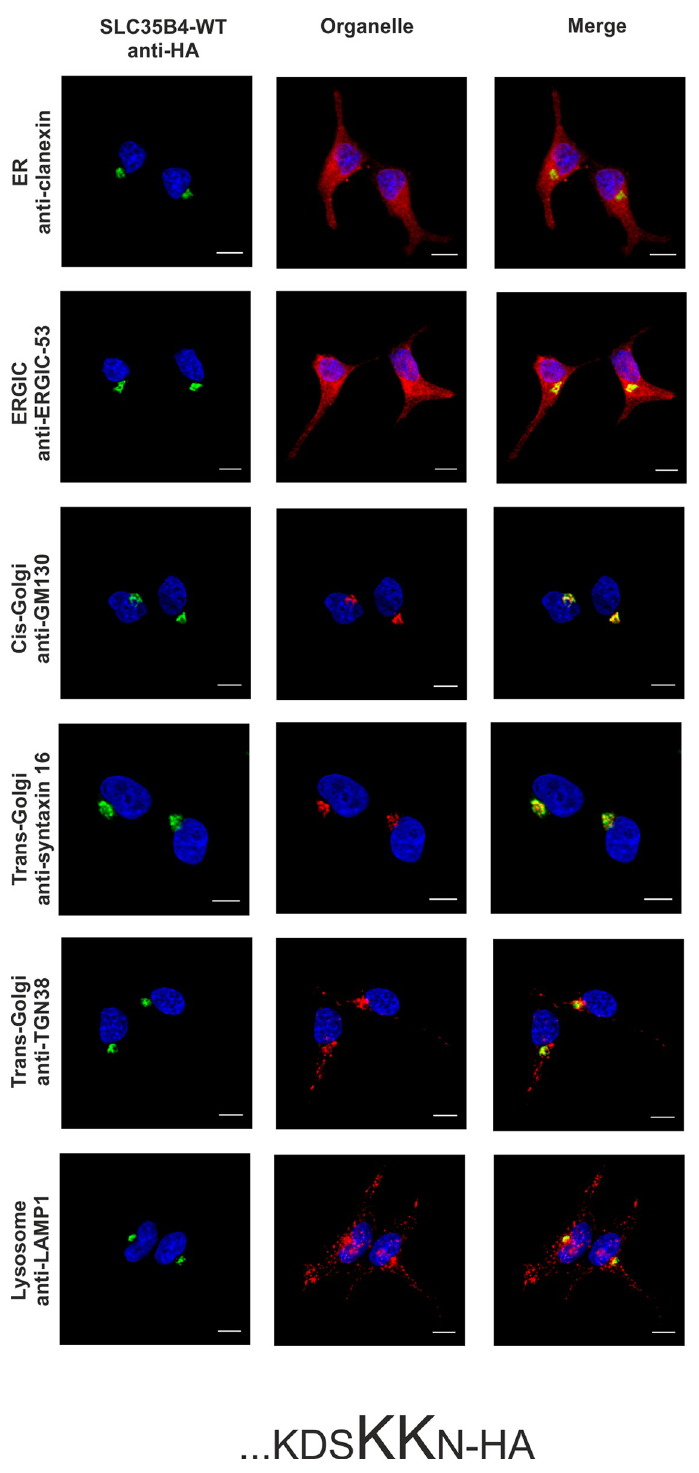
Fig 2. Subcellular localization of ... KDSKKN-HA, human SLC35B4 with HA-epitope at the C-terminus in the wild-type HepG2 cells. Stably transfected wild-type (SLC35B4-WT) cells, overexpressing SLC35B4 variants, were subjected to indirect immunofluorescent staining with anti-HA (green) and anti-organelle markers (Table 3) (red) antibodies. Cell nuclei were counterstained with DAPI. Scale bar 10 μ m.